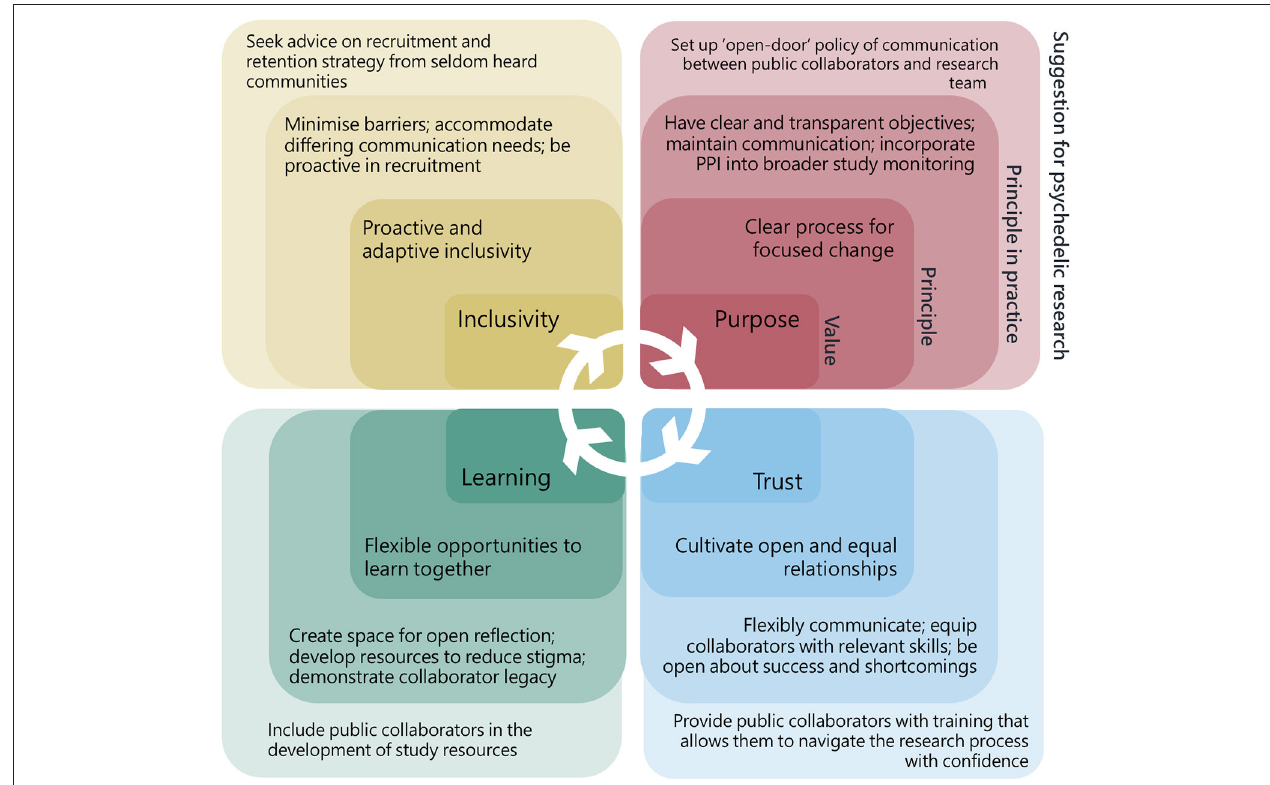
FIGURE 3 | Values, principles, principles in practice, and suggestions for patient and public involvement in psychedelic research. Every value is relevant to all four areas of PPI and also bring more specific principles on which to build specific actions.